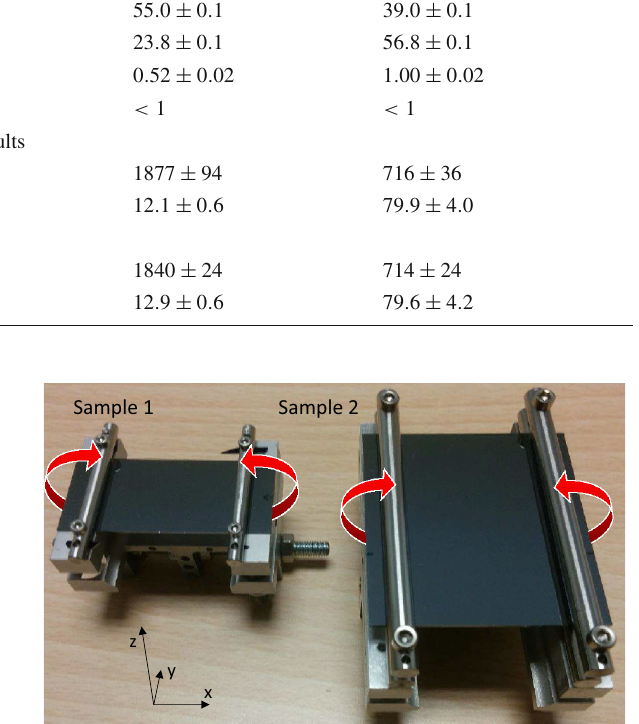
multiple scattering of the proton beam and it would be a contaminant for the pipe of